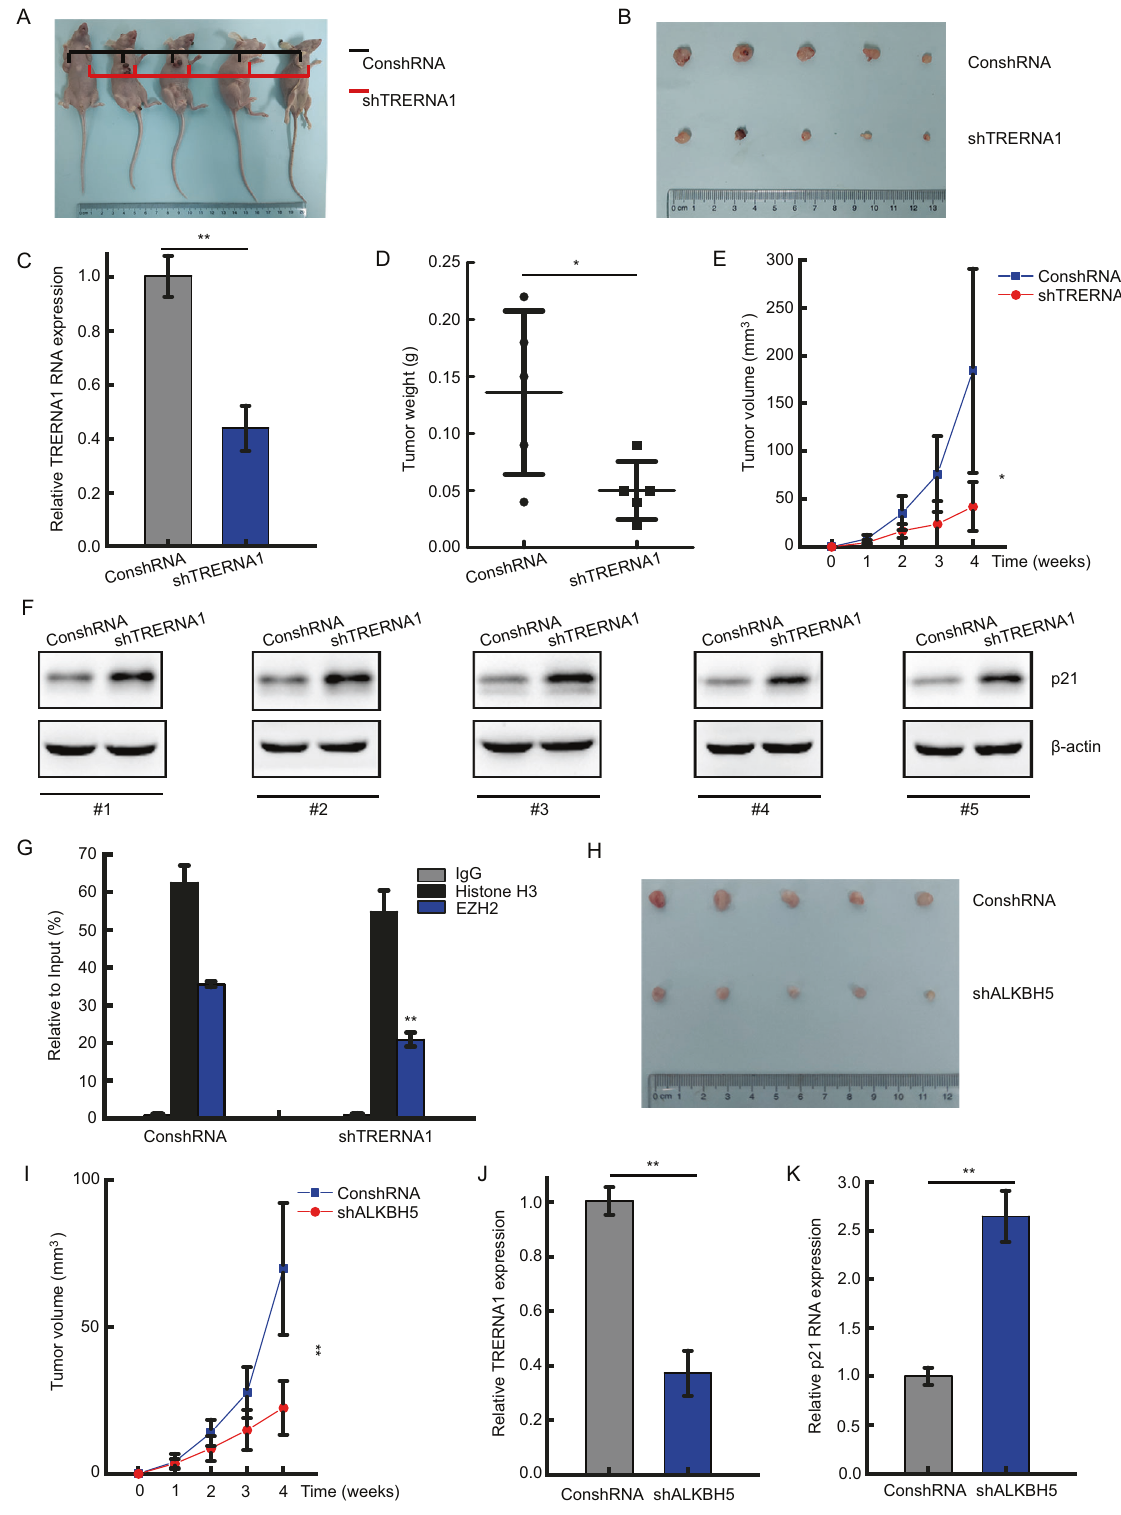
Fig. 6 TRERNA1 promotes DLBCL tumorigenesis in vivo. A , B Tumor growth model showed that BALB/c nude mice were injected with stable shTRERNA1 knockdown and control SU-DHL4 cells via subcutaneous injection. C TRERNA1 expression in tumors detected by RT-qPCR. D Weights of the formed tumors. E Tumor volume growth curves. F p21 expression in tumors detected by western blot analysis. G The enrichment of EZH2 at the p21 promoter when TRERNA1 was decreased in the xenograft. H Tumor growth model showed that BALB/c nude mice were injected with stable ALKBH5 knockdown and control SU-DHL4 cells via subcutaneous injection. I Tumor volume growth curves with stable ALKBH5 knockdown and control SU-DHL4 cells. J TRERNA1 expression in tumors detected by qRT-PCR. K p21 expression in tumors detected by qRT-PCR. The data are presented as the mean ± SD; * P < 0.05, ** P <